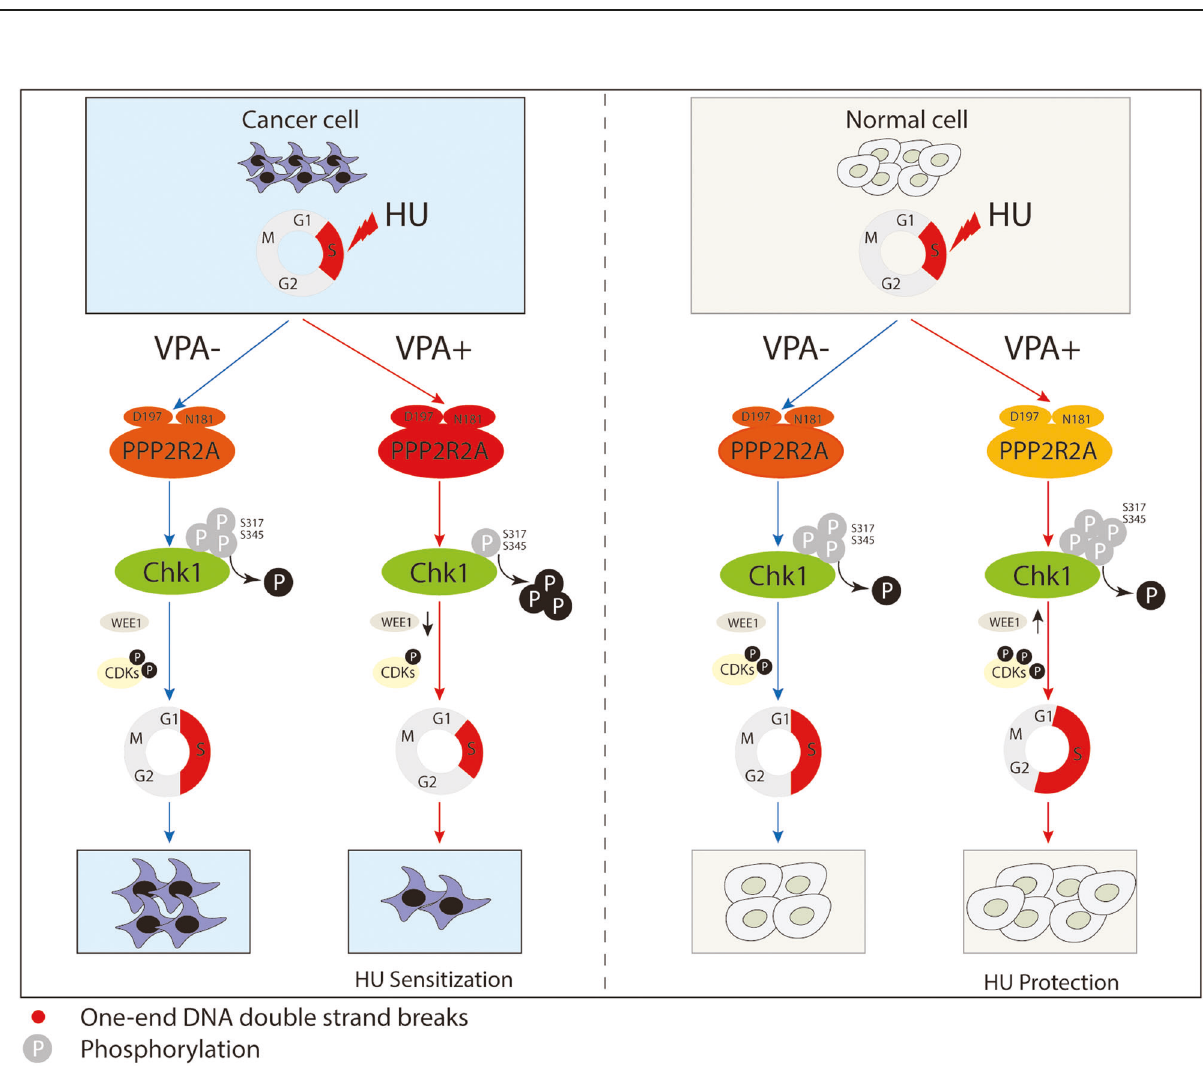
Fig. 8 Association of the expression of PPP2R2A and pChk1 with the prognosis of patients with breast cancer. A Representative IHC images (magni fi cation 10 and 50) of pChk1-S317 and PPP2R2A staining in a microarray consisting of 137 samples derived from breast cancer patients. Zoomed images show the details of the area denoted with a black square. Bar, 100 μ m. Quanti fi cation of IOD density of pChk1-S317 and PPP2R2A from the representative IHC images. B PPP2R2A level negatively correlates with pChk1-S317 level in breast cancer patient tissues. H-Score is calculated using Aipathwell ( n = 137). Student ’ s t -test. ** P < 0.01. Tumor Node Metastasis (TNM) stage ( C ), lymph node metastasis ( D ), tumor size ( E ), and pathological type ( F ) had no effect on the expression of pChk1-S317 and PPP2R2A in tumor tissues. Quanti fi cation of pChk1-S317 and PPP2R2A in breast cancer patients with different TNM stages (TNM-I ( n = 23), TNM-II ( n = 76), TNM-III ( n = 34)) ( C ), lymph node involvement (N0 ( n = 43), N1 (n = 46)) ( D ), tumor size (pT1 ( n = 38), pT2 ( n = 84), pT3 ( n = 13)) ( E ), Histological type (IDC: invasive ductal carcinoma ( n = 118); No-IDC: non-invasive ductal carcinoma ( n = 19)) ( F ) is shown. ** P < 0.01. ( G , H ) High levels of pChk1- S317 or low levels of PPP2R2A predicate the worst prognosis in breast cancer patients. Survival analysis of patients with PPP2R2A/pChk1-S317 at high or low levels is shown (PPP2R2A: L : n = 69, H : n = 69; pChk1-S317: L : n = 93, H : n = 45). P < 0.05. I , J The prognostic value of mRNA levels of PPP2R2A and Chk1 in breast cancer patients was analyzed by Kaplan-Meier Plotter. P < 0.05. K , L The correlation between PPP2R2A and Chk1 expression and tumor stage in breast cancer patients was analyzed using the GEPIA database. ** P <